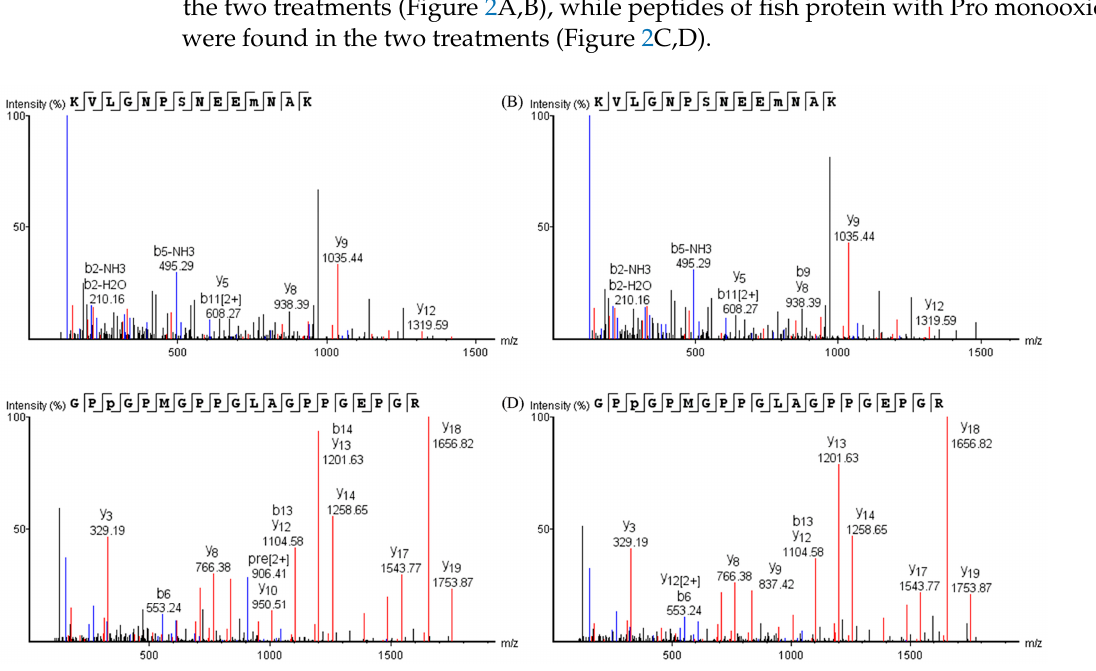
Figure 2. Representative examples of oxidatively modified peptides which were identified. MS/MS spectrum of the peptide KVLGNPSNEEM(O)NAK derived from pork samples treated with CW ( A ) and OM ( B ); MS/MS spectrum of the peptide GPP(O)GPMGPPGLAGPPGEPGR derived from fish samples treated with CW ( C ) and OM ( D ). CW: conventional water-washing; OM: ozone-microbubbles-washing.